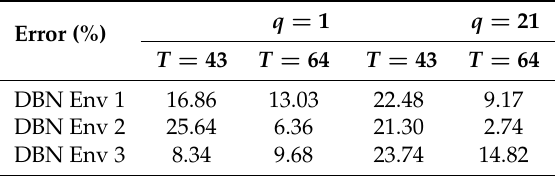
Figure 2. Prediction of the LAI with prediction length q = 21 for micro-tomatoes (MicroTom) with sparse data in three environments: Env 1 (warm and bright), Env 2 (shaded and emergency heating), and Env 3 (indoor and artificial illumination). LRM, Linear time-series Regression Model. Table 2. Prediction error of LAI vs. GDT for MicroTom with sparse data in three environments: Env 1 (warm and bright), Env 2 (shaded and emergency heating), and Env 3 (indoor and artificial